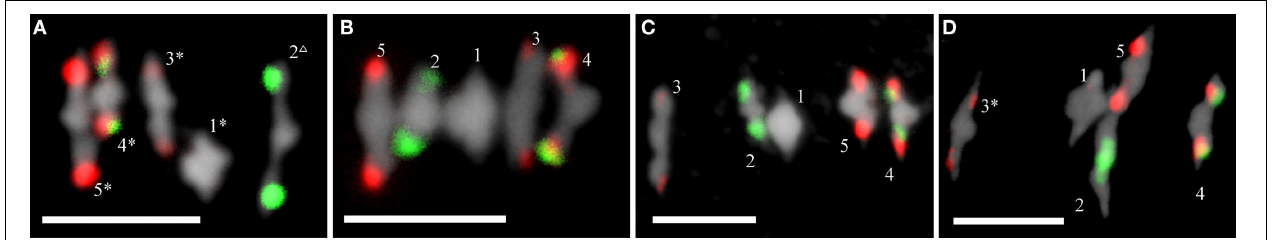
FIGURE 4 | FISH images of metaphase I cells from wild-type, ago2-1 , ago5-4 , and ago9-1 plants. (A) Col. (B) ago2-1 . (C) ago5-4 . (D) ago9-1 . 45S and 5S rDNA loci are identified by green and red signals, respectively.